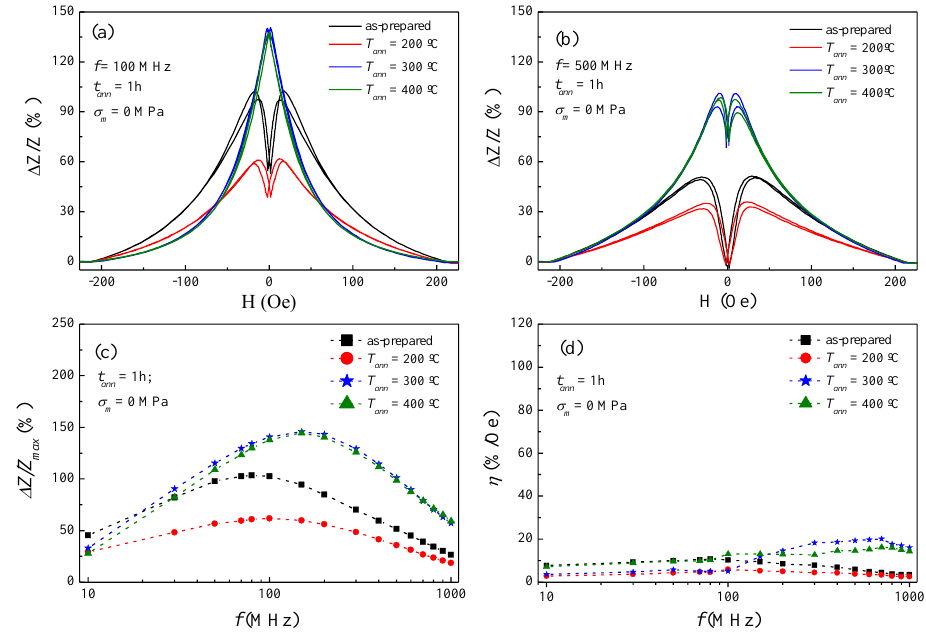
Figure 3. Field dependence of the GMI ratio for the as-prepared and annealed Co 69.2 Fe 3.6 Ni 1 B 12.5 Si 11 Mo 1.5 C 1.2 microwires measured at representative frequencies: ( a ) 100 MHz and ( b ) 500 MHz; ( c ) frequency dependence of ∆ Z / Z max , and (d) field sensitivity. Dashed-lines in ( c ) and ( d ) are a guide to the eye, while full-symbols denote experimental data.